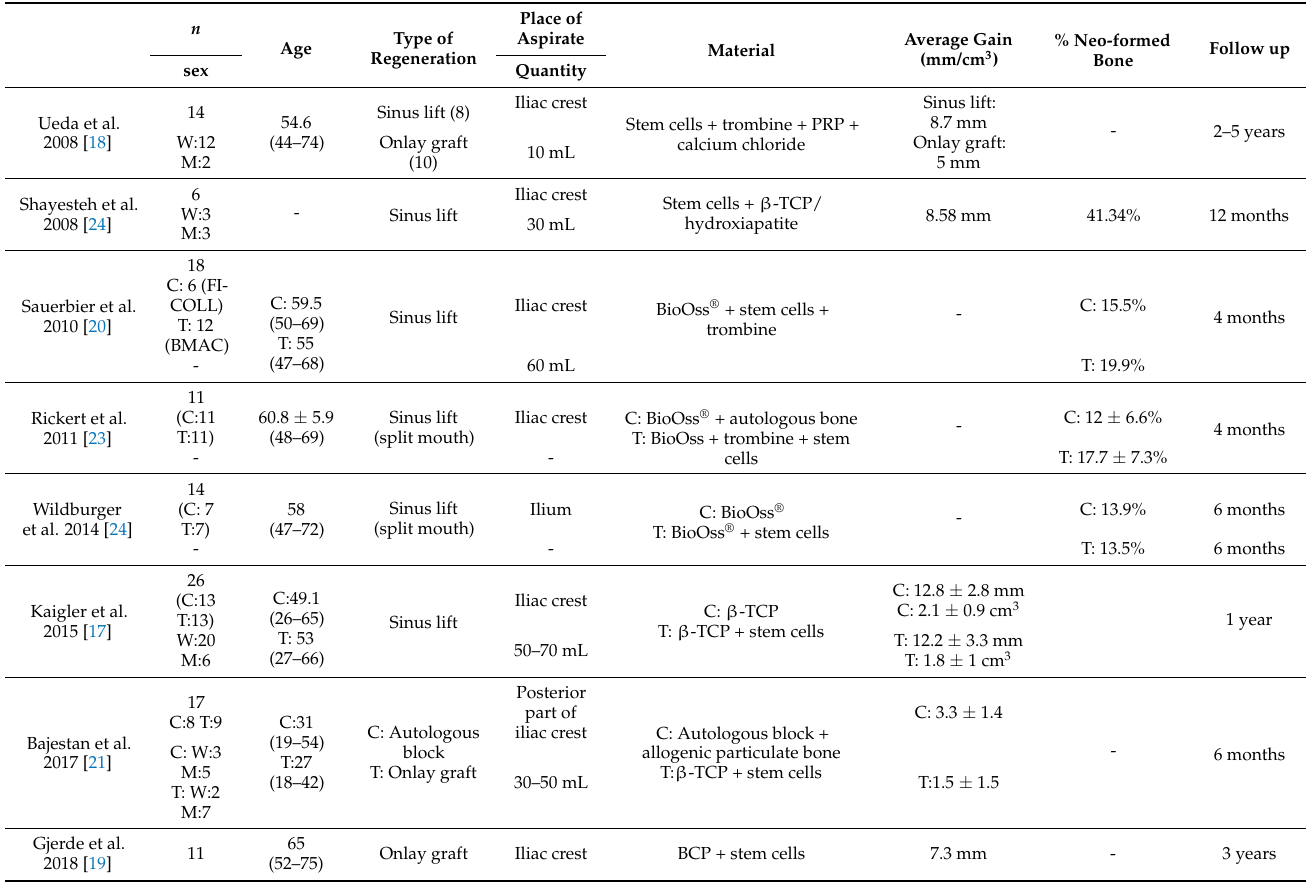
Table 3. Characteristics of the